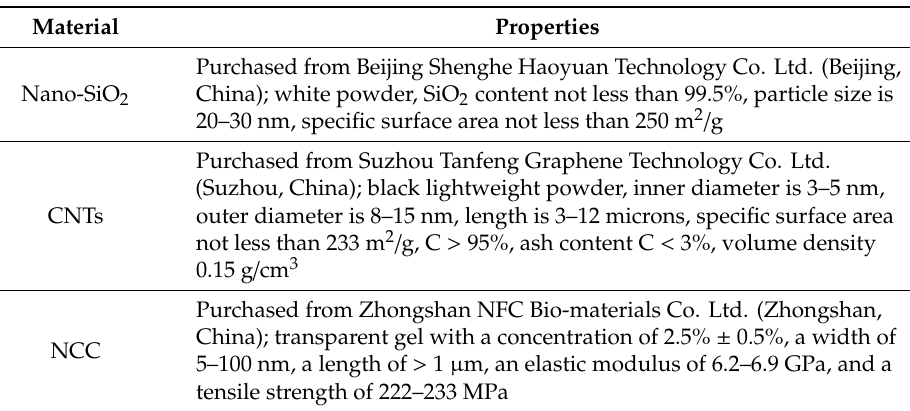
Table 1. Technical indexes of the